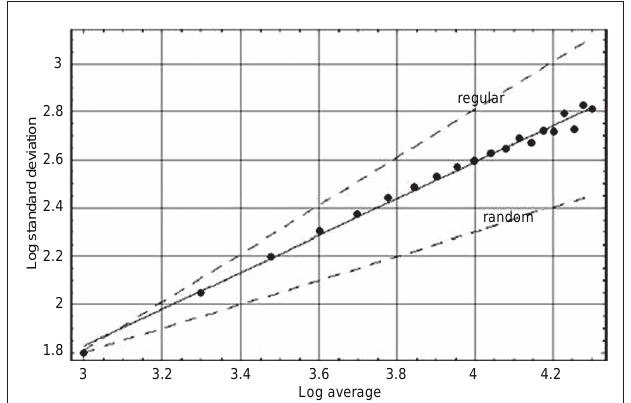
Figure 2 | The logarithm of the standard deviation is plotted versus the logarithm of the average value for the heartbeat interval time series for a young adult male, using sequential values of the aggregation number (West, 2006a). The solid line segment is the best fit to the aggregated data points and yields a fractal dimension D = 1.24 midway between the curve for a regular process ( D = 1) and that for an uncorrelated random process ( D = 1.5) as indicated by the dashed